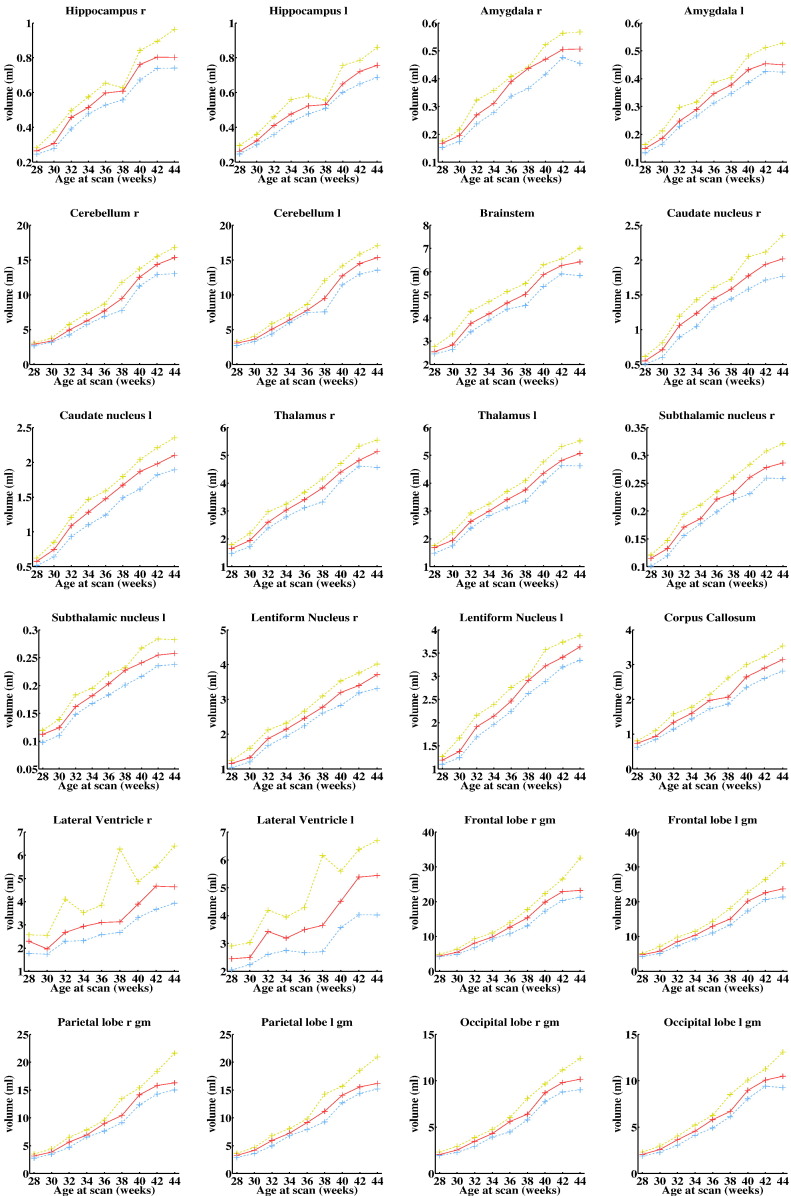
Volume(mL) centiles of the 82 structures of the whole brain with increasing scan age. The yellow line for each region represents the 25% centile over the subjects in the database, the red line the median value, and the blue line the 75% centile.